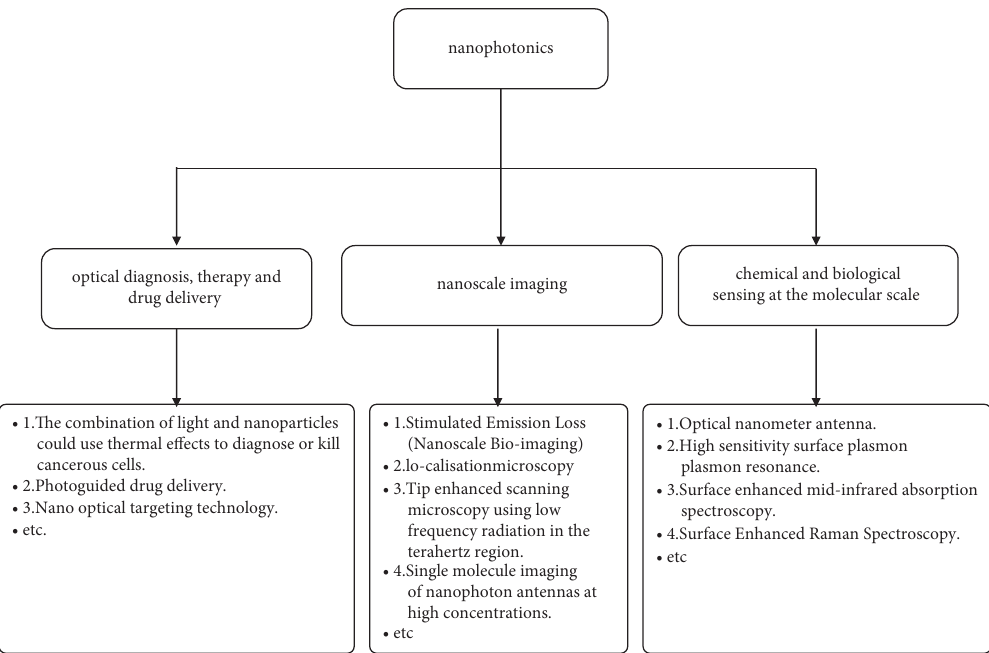
Figure 2: Current major technologies in